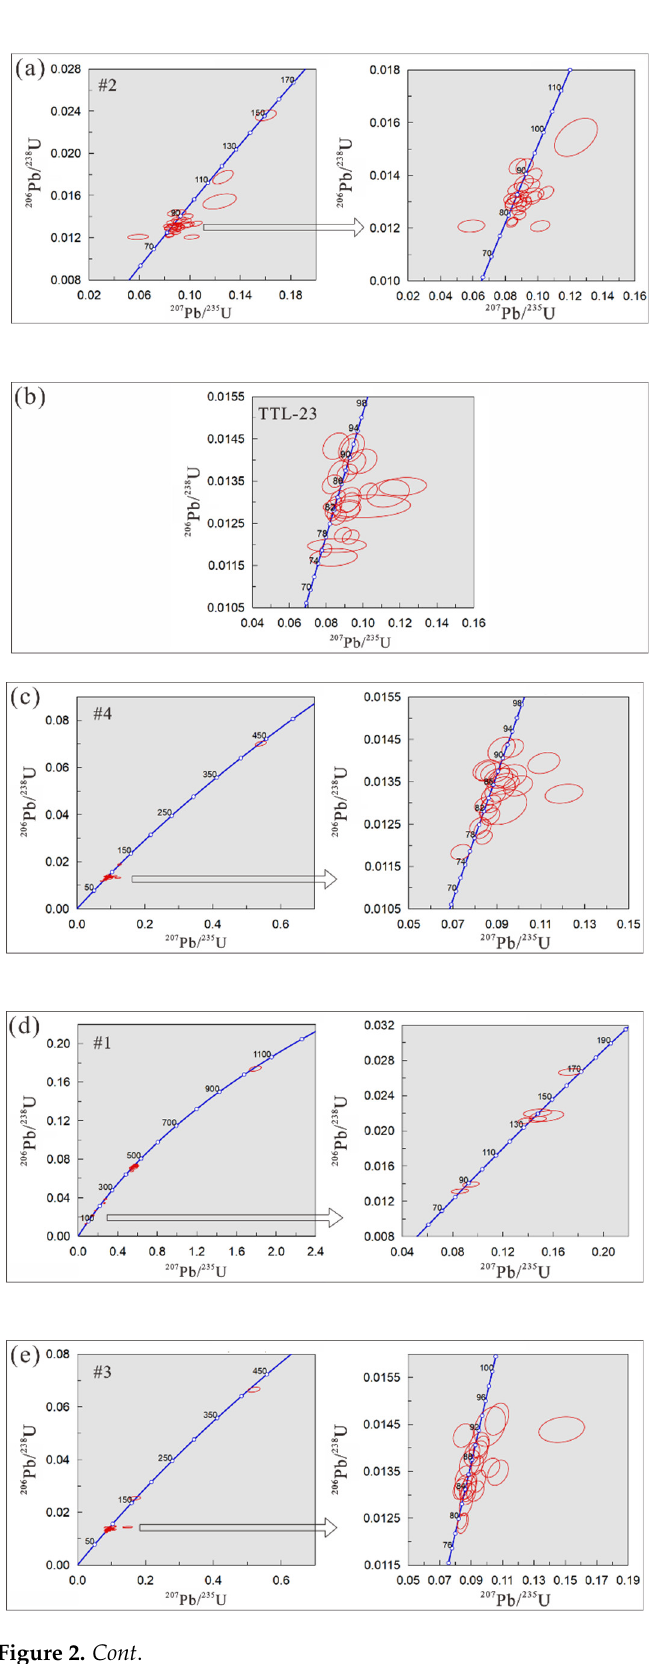
Figure 2. Zircon dating U-Pb concordia diagrams for this study. ( a ) sample #2, ( b ) sample TTL-23 and ( c ) sample #4 are country rock. ( d ) sample #1, ( e ) sample #3, ( f ) sample MKZ2-A90 are fault rock and ( g ) sample #7.